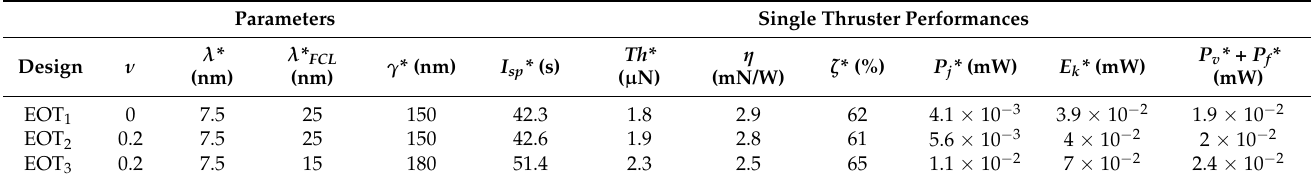
Table 1. The performance features of three single modeled electroosmotic thrusters in soft nanochannels, namely EOT 1 , EOT 2 and EOT 3 , with consideration of the steric effect. Parameters Single Thruster Performances